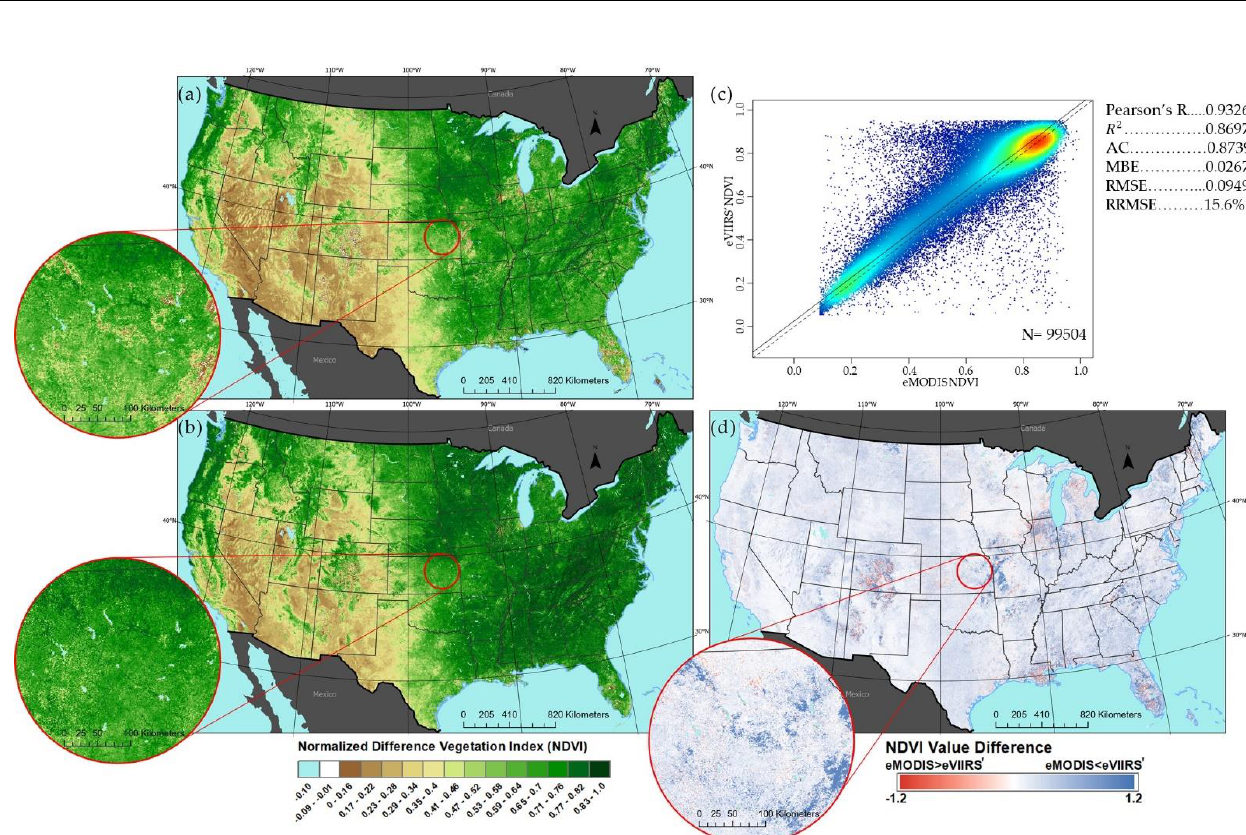
Figure 4. Expedited Moderate Resolution Imaging Spectroradiometer (eMODIS) ( a ) and transformed expedited Visible Infrared Imaging Radiometer Suite (eVIIRS’) ( b ) Normalized Difference Vegetation Index (NDVI) comparison for Week 32, 2020, at 1-km resolution. ( c ) Statistical comparison between eVIIRS’ and eMODIS for Week 32, 2020, which is one composite from the 2020 1-km column in Table 1. Point density increases from low (blue) to moderate (green) to high (red), the geometric mean regression (solid line) and the 1-to-1 line (dashed line). ( d ) Differences between each pixel whether eMODIS NDVI is greater than eVIIRS’ NDVI (red) or eVIIRS’ is greater than eMODIS (blue).